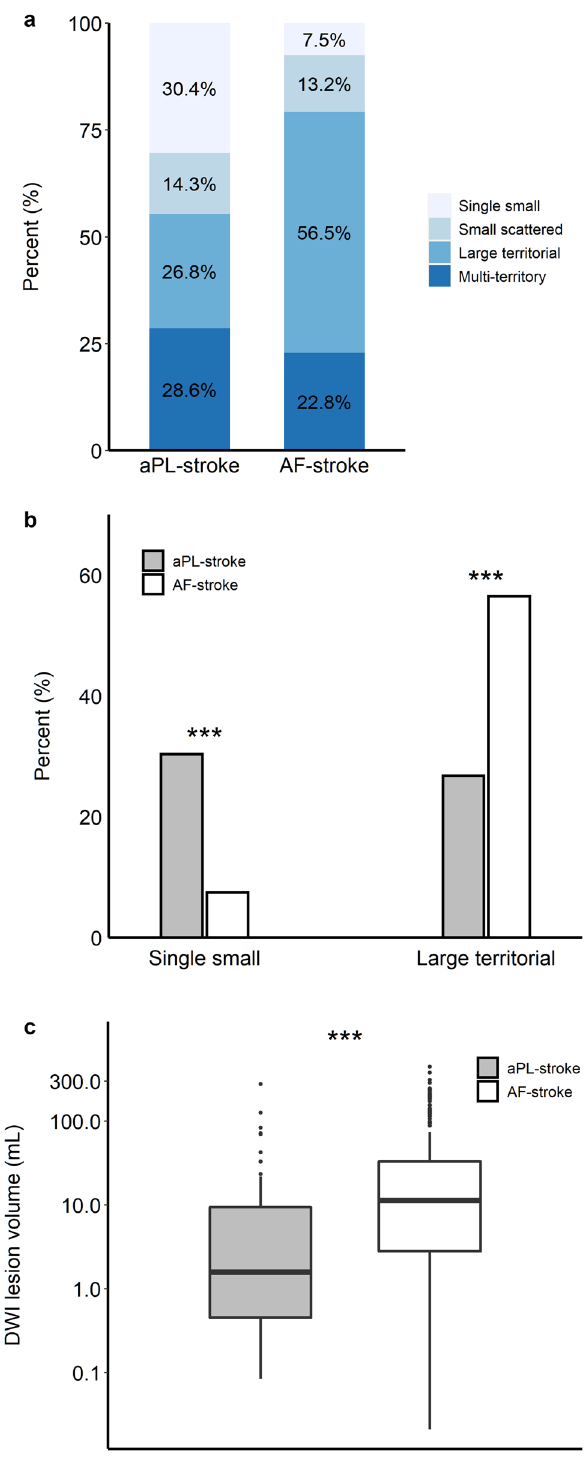
Figure 2. Neuroimaging features of aPL- and AF-stroke patients. ( a ) Lesion pattern based on the size and distribution of aPL- and AF-stroke patients. A single small lesion, solitary lesion ≤ 15 mm; small scattered lesion in a single territory, multiple scattered lesions with the largest lesion size ≤ 15 mm; large territorial lesion, lesion > 15 mm involving single vascular territory; and multi-territory lesion, multiple lesions involving multiple vascular territories. ( b ) Comparison of representative lesion patterns in aPL- and AF-stroke patients. ( c ) Total DWI lesion volumes of aPL- and AF-stroke patients. DWI lesion volume is presented on the y-axis as a log scale. *** p < 0.001. AF-stroke atrial fibrillation-related stroke, aPL-stroke antiphospholipid antibody-related stroke, DWI diffusion-weighted